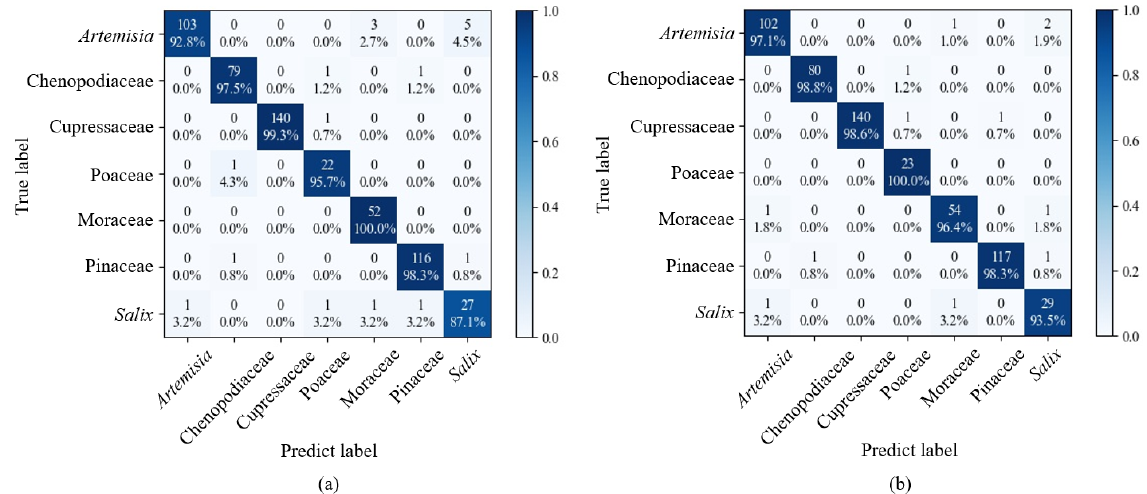
Figure 8. The confusion matrices for the “Multi-Scale + Selector + Deblur” process with the VGG-19 and Resnet-50 backbones: ( a ) the confusion matrix of the multi-scale classifier with the VGG-19 backbone; ( b ) the confusion matrix of the multi-scale classifier with the Resnet-50 backbone. The lighter blue colors represent lower values and darker blue colors represent higher values. The columns represent the true pollen labels while the rows represent the predicted labels that were classified by the multi-scale